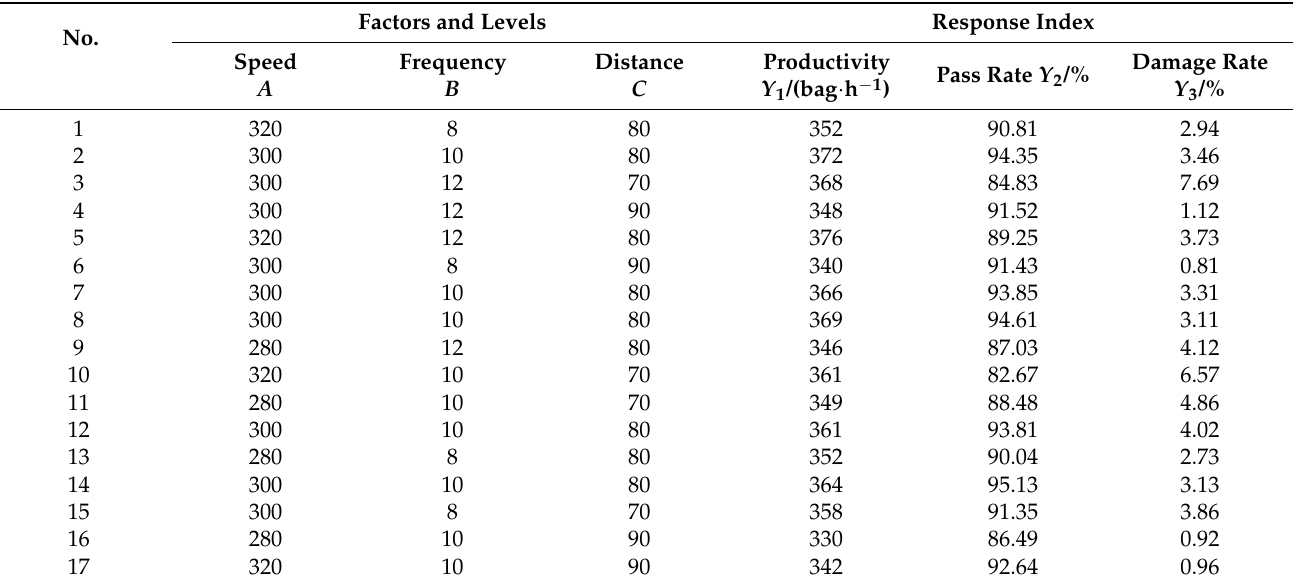
Table 2. Result and design of